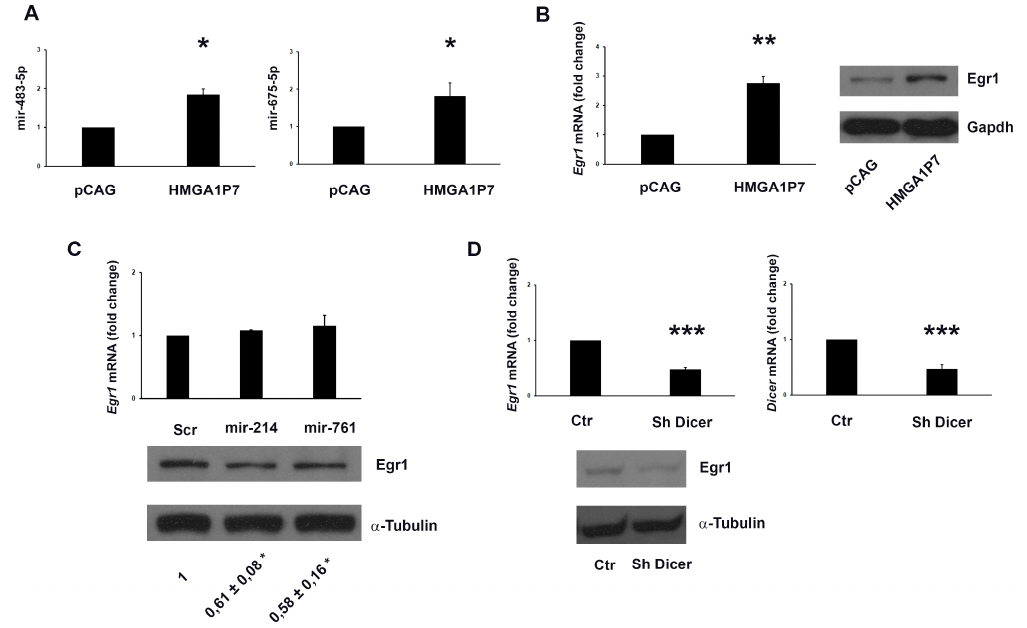
Figure 4. Egr1 is positively regulated by HMGA1P7 through ceRNA connection. ( A ) qRT-PCR analysis of mir-483-5p and mir-675-3p from control and overexpressing NIH3T3 cells. ( B ) Left panel, qRT-PCR analysis of Egr1 from control and HMGA1P7 overexpressing NIH3T3 cells. Right Panel, Western blot analysis of Egr1 from control and HMGA1P7 overexpressing NIH3T3 cells. ( C ) Upper panel, qRT-PCR analysis of Egr1 mRNA from the NIH3T3 cells transfected with scrambled-oligonucleotide, miR-214, miR-761. Lower panel, a representative Western blot analysis of Egr1 in the same samples as in the upper panel. Densitometric analysis of Western blot assays for Egr1 is also reported. ( D ) Upper panel, Egr1 and Dicer mRNA levels 24 h after the transfection of scrambled oligonucleotide or siRNA-Dicer in HMGA1P7 NIH3T3 overexpressing cells. Lower Panel, Western blot analysis of Egr1 in the same samples as in the upper panels. The results are reported as the mean of values. The error bars represent mean ± SD; *: p < 0.05, **: p < 0.01, ***: p < 0.001 (t test).